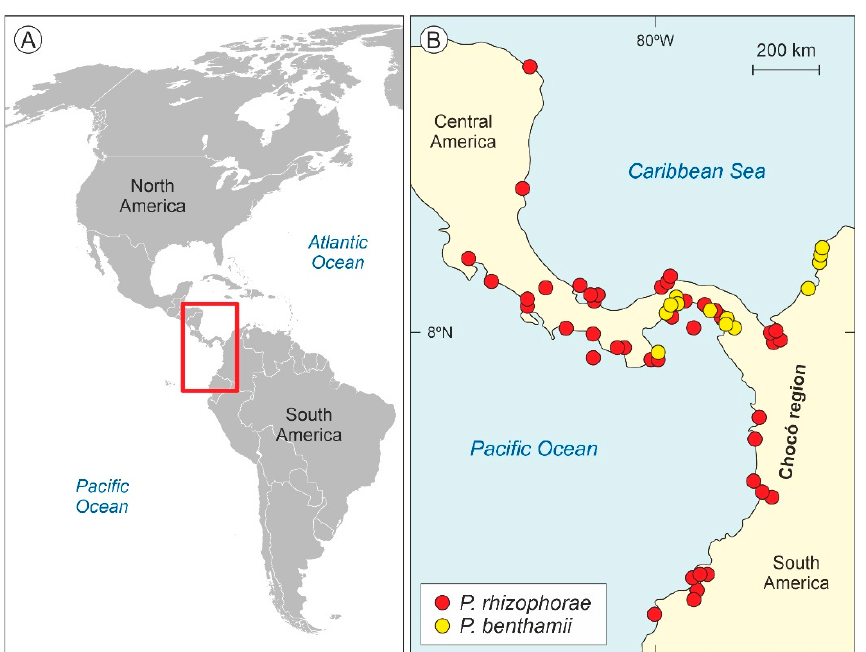
Figure 2. Present distribution of Pelliciera species. ( A ) Map of the Americas with the distribution area of Pelliciera highlighted by a red box. ( B ) Close up of the occurrence patterns of the two Pelliciera species (modified from Ref. [38]). The Colombian Chocó region is highlighted because it is one of the most humid regions of the world, with precipitation values up to 13,000 mm y − 1 [46].